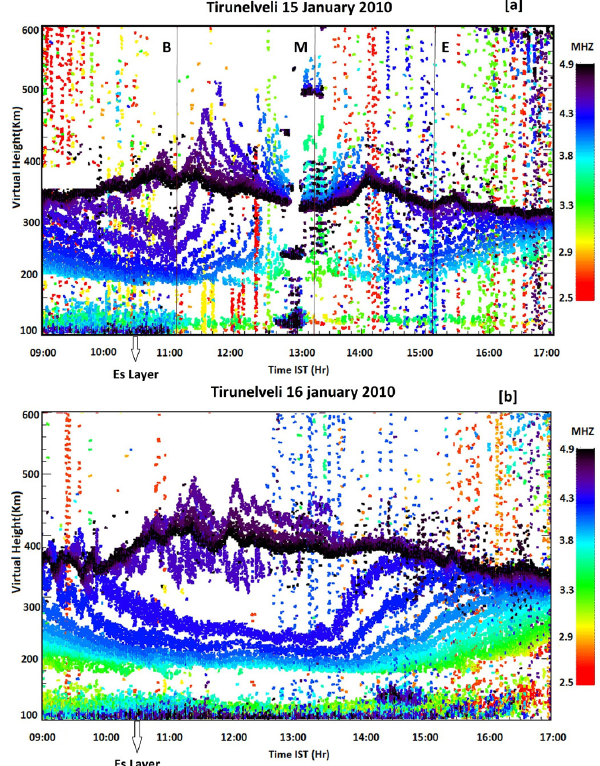
Fig. 3. Virtual height-time-frequency map observed by CADI at Tirunelveli on (a) 15 January and (b) 16 January